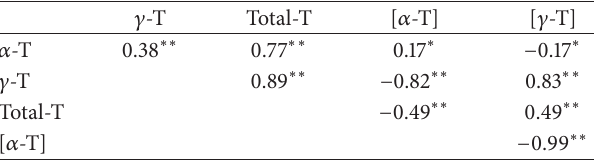
Table 5: Correlation coefficients between 𝛼 -tocopherol content ( 𝛼 -T), 𝛾 -tocopherol content ( 𝛾 -T), and total tocopherol content (total-T), expressed as mgkg −1 seed, and relative concentrations of 𝛼 -tocopherol ([ 𝛼 -T]) and 𝛾 -tocopherol ([ 𝛾 -T]), expressed as percentage of the total tocopherols.